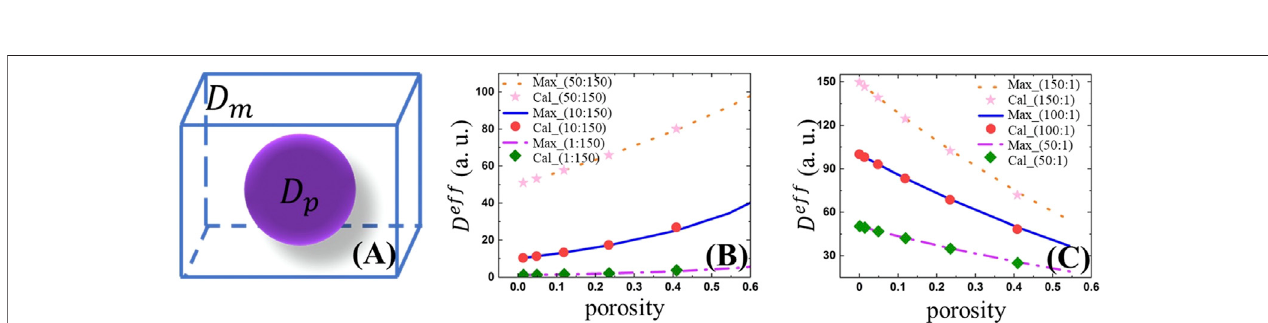
FIGURE 2 | (A) A spherical phase is embedded in a cubic box. Comparison of simulated and analytical effective diffusion coef fi cients as a function of the volume fraction of the spherical phase for three different diffusion coef fi cient ratios (B) D p / D m > 1.0 and (C) D p / D m < 1.0. The scatter points represent the simulation results, and the curves represent the results calculated by the Maxwell-Garnett model (Maxwell, 1881; Moradi, 2015).